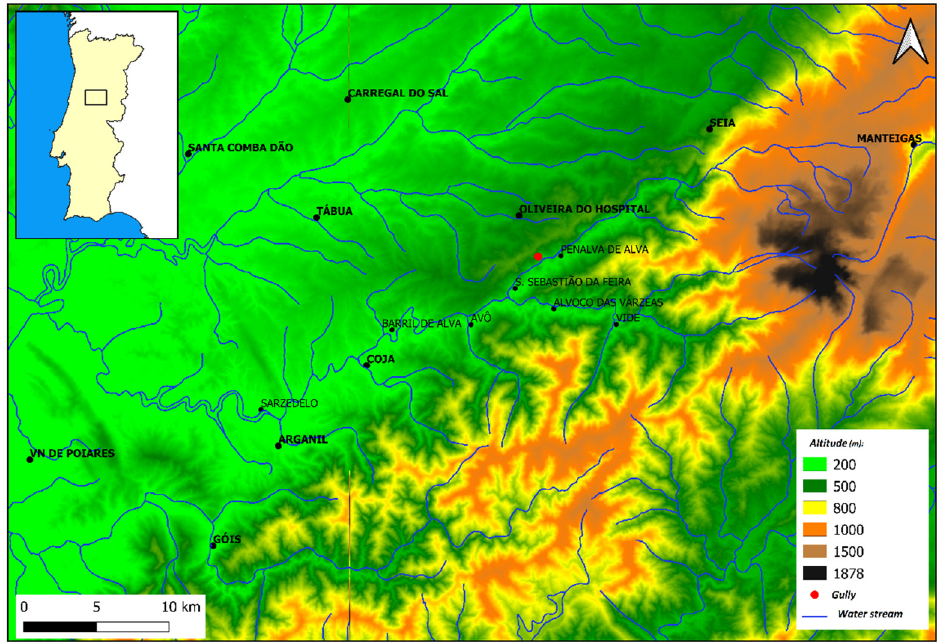
Figure 1. Location of the study area and gully.